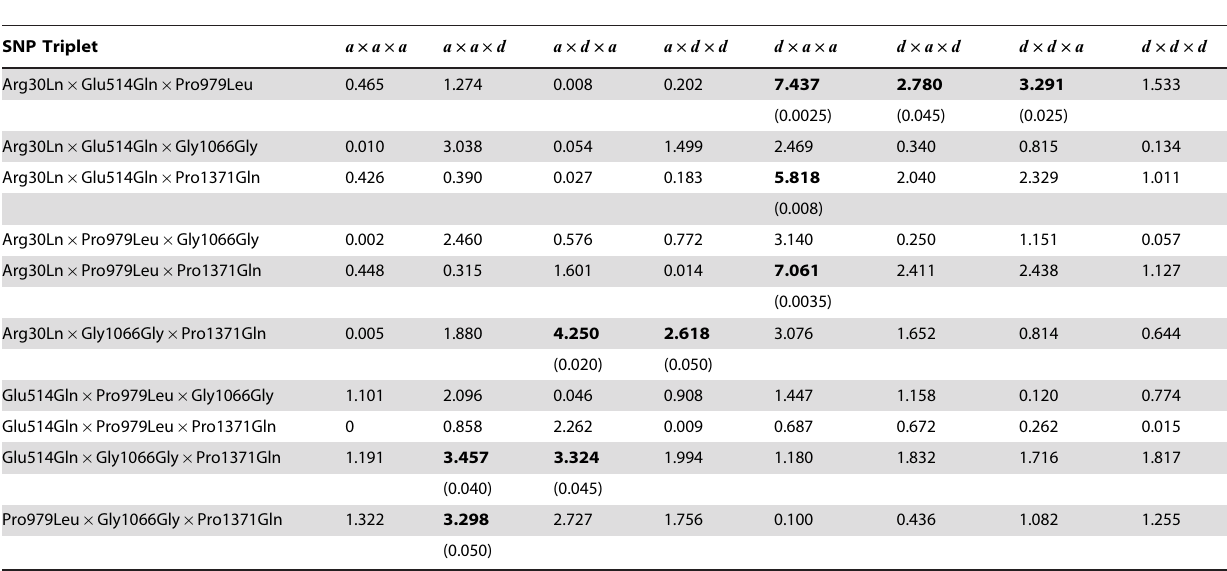
Table 8. The x 2 test statistics calculated to test the three-SNP epistasis between each pair of SNPs genotyped from DLG5.